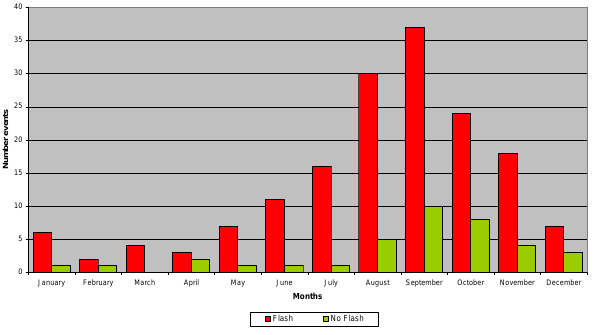
Figure 5. Distribution of flash flood events and non flash-flood events recorded in Fig. 5. Distribution of flash flood events and non flash-flood events Catalonia for the period 1982-2007 recorded in Catalonia for the period 1982–2007.